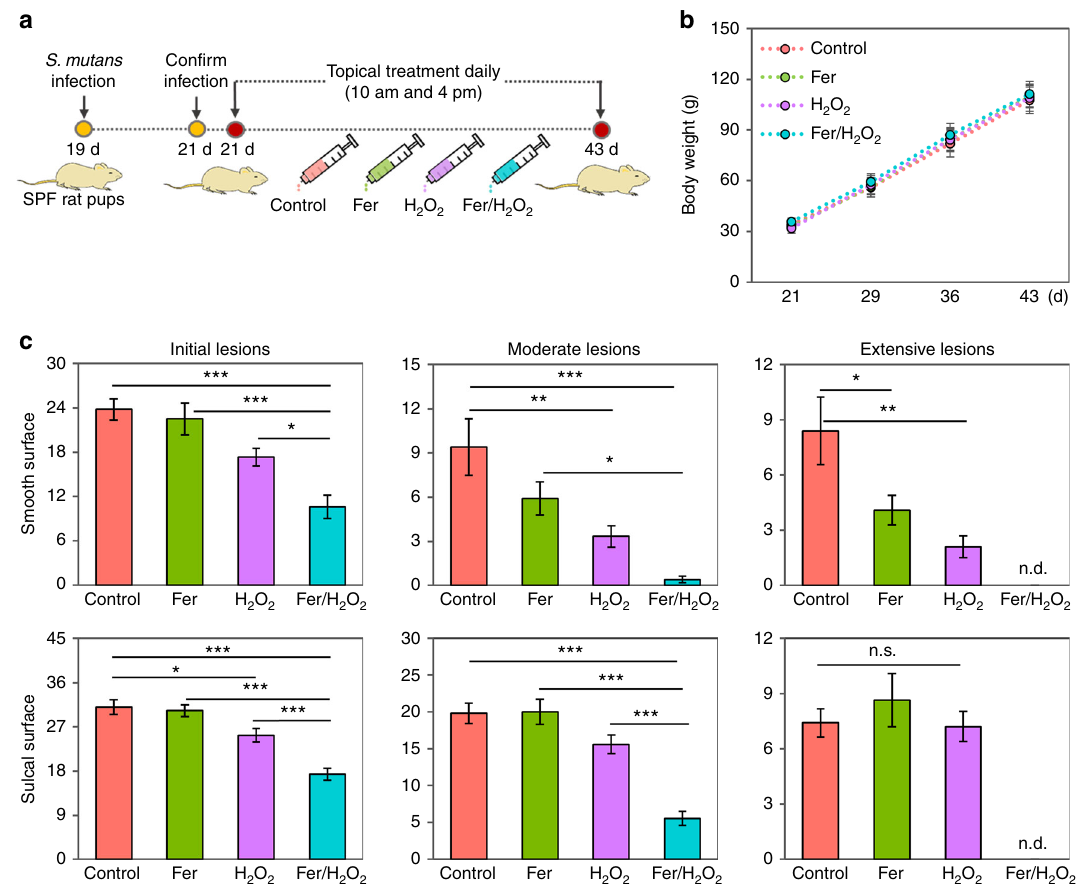
Fig. 6 Therapeutic ef fi cacy of topical ferumoxytol/H 2 O 2 against a bio fi lm-associated oral disease (tooth decay) in vivo. In this model, tooth-enamel progressively develop caries lesions (analogous to those observed in humans), proceeding from initial areas of demineralization to moderate lesions and on to extensive (severe) lesions characterized by enamel structure damage and cavitation. a Experimental design and treatment regimen. b Body weights of rat pups during the experimental period. c Caries onset and severity of both smooth and sulcal surfaces. Caries scores were recorded as stages and extent of carious lesion severity according to Larson ’ s modi fi cation of Keyes ’ scoring system 26,27 . The data presented as mean ± s.d. ( n = 10), and one-way ANOVA with post hoc Tukey HSD test was used for a multiple comparison. * P < 0.05, ** P < 0.01, *** P < 0.001; n.d. nondetectable; n.s. nonsigni fi